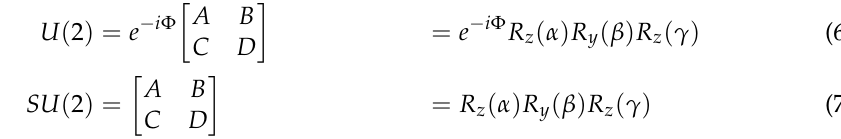
Figure 5. Minimal universal quantum circuit for a one-qubit gate [15].